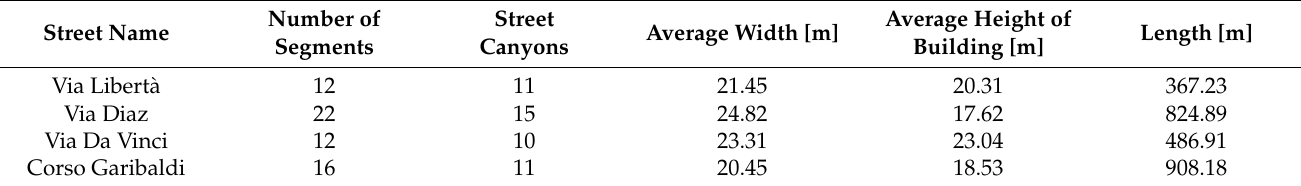
Table 1. Overview of the characteristics of the monitoring